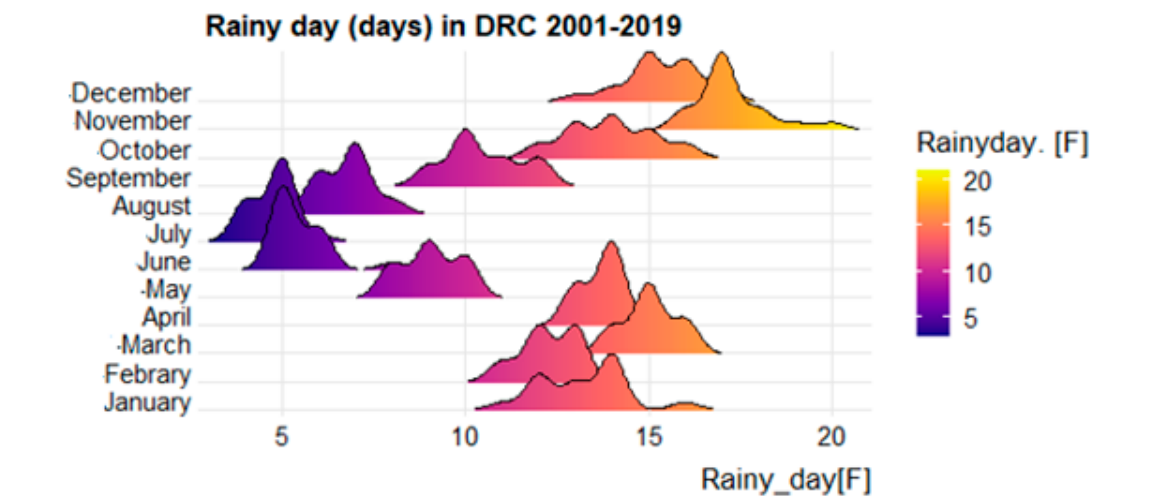
Figure A5. Minimal temperature (°C) in DRC (2001–2019).